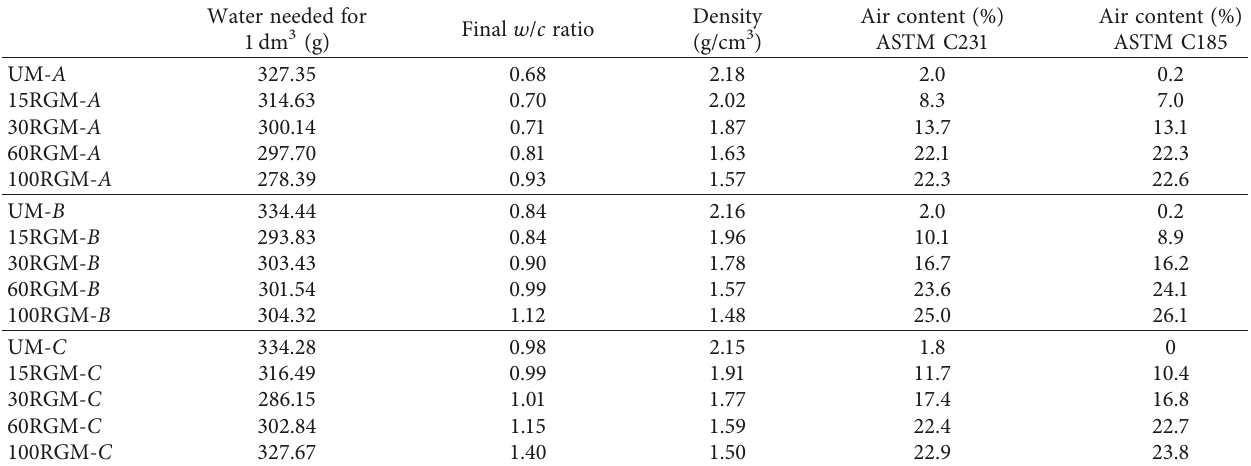
Table 3: Results of the fresh-state properties of RGM.